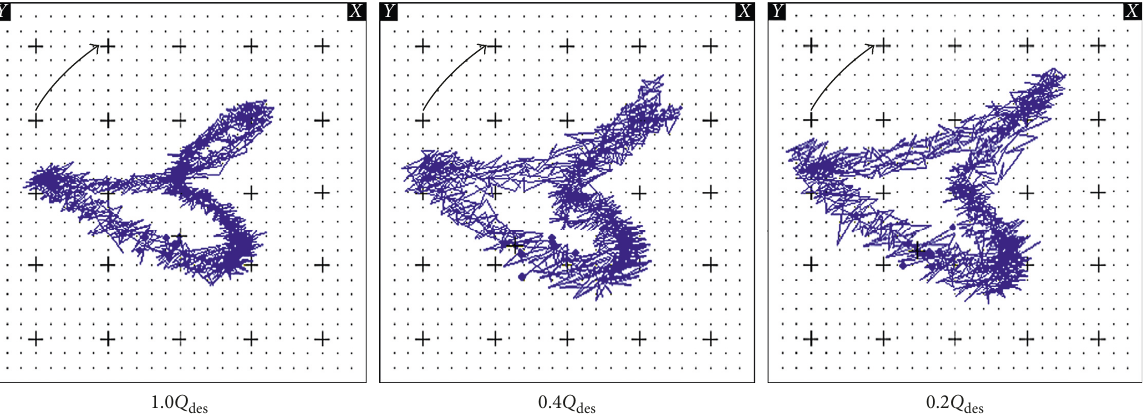
des , (b) 0.4 Q des , and (c) 0.2 Q des .